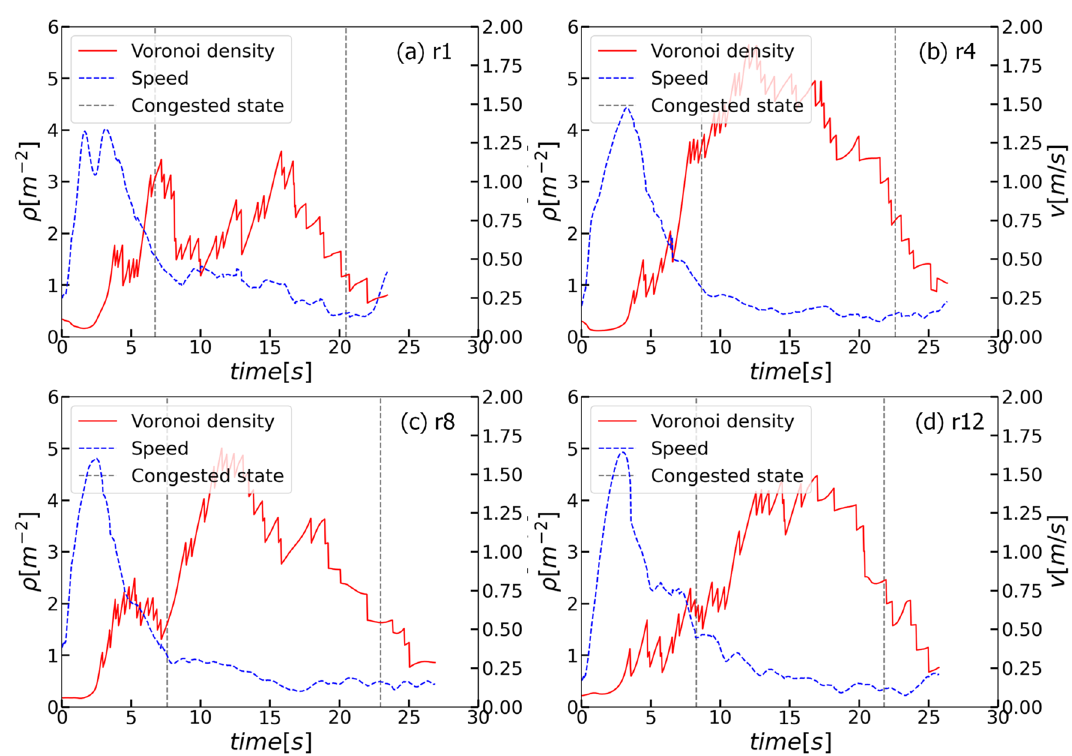
Figure 4. Time profiles of density and speed in the measurement area. ( a ) r1. ( b ) r4. ( c ) r8. ( d ) r12. Red solid lines represent the time profiles of density and blue dashed lines represent the time profiles of speed. The range between grey dashed lines represent the selected congested state. See Appendix C for the time profiles in other experimental